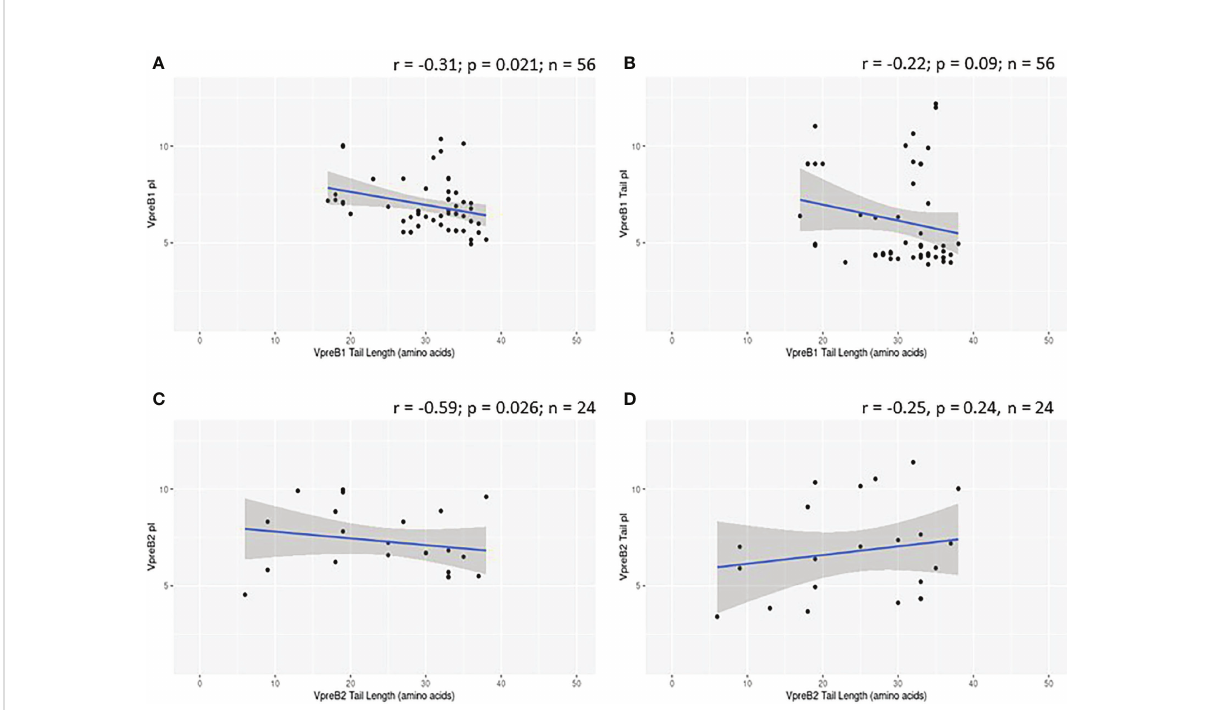
FIGURE 7 VpreB tail length is negatively correlated with isoelectric point (pI) of tail residues. (A) pI and length of VpreB1 tail regions show a weak negative correlation (r = -0.31; p = 0.021; n = 56), though (B) this relationship is not due to pI of VpreB1 tail residues (r = -0.22; p = 0.09; n = 56). (C) pI and length of VpreB2 tail regions show a moderate negative correlation (r = -0.59; p = 0.026; n = 24), and this (D) relationship was unrelated to pI of VpreB2 tail residues (r = -0.25; p = 0.24; n =24).